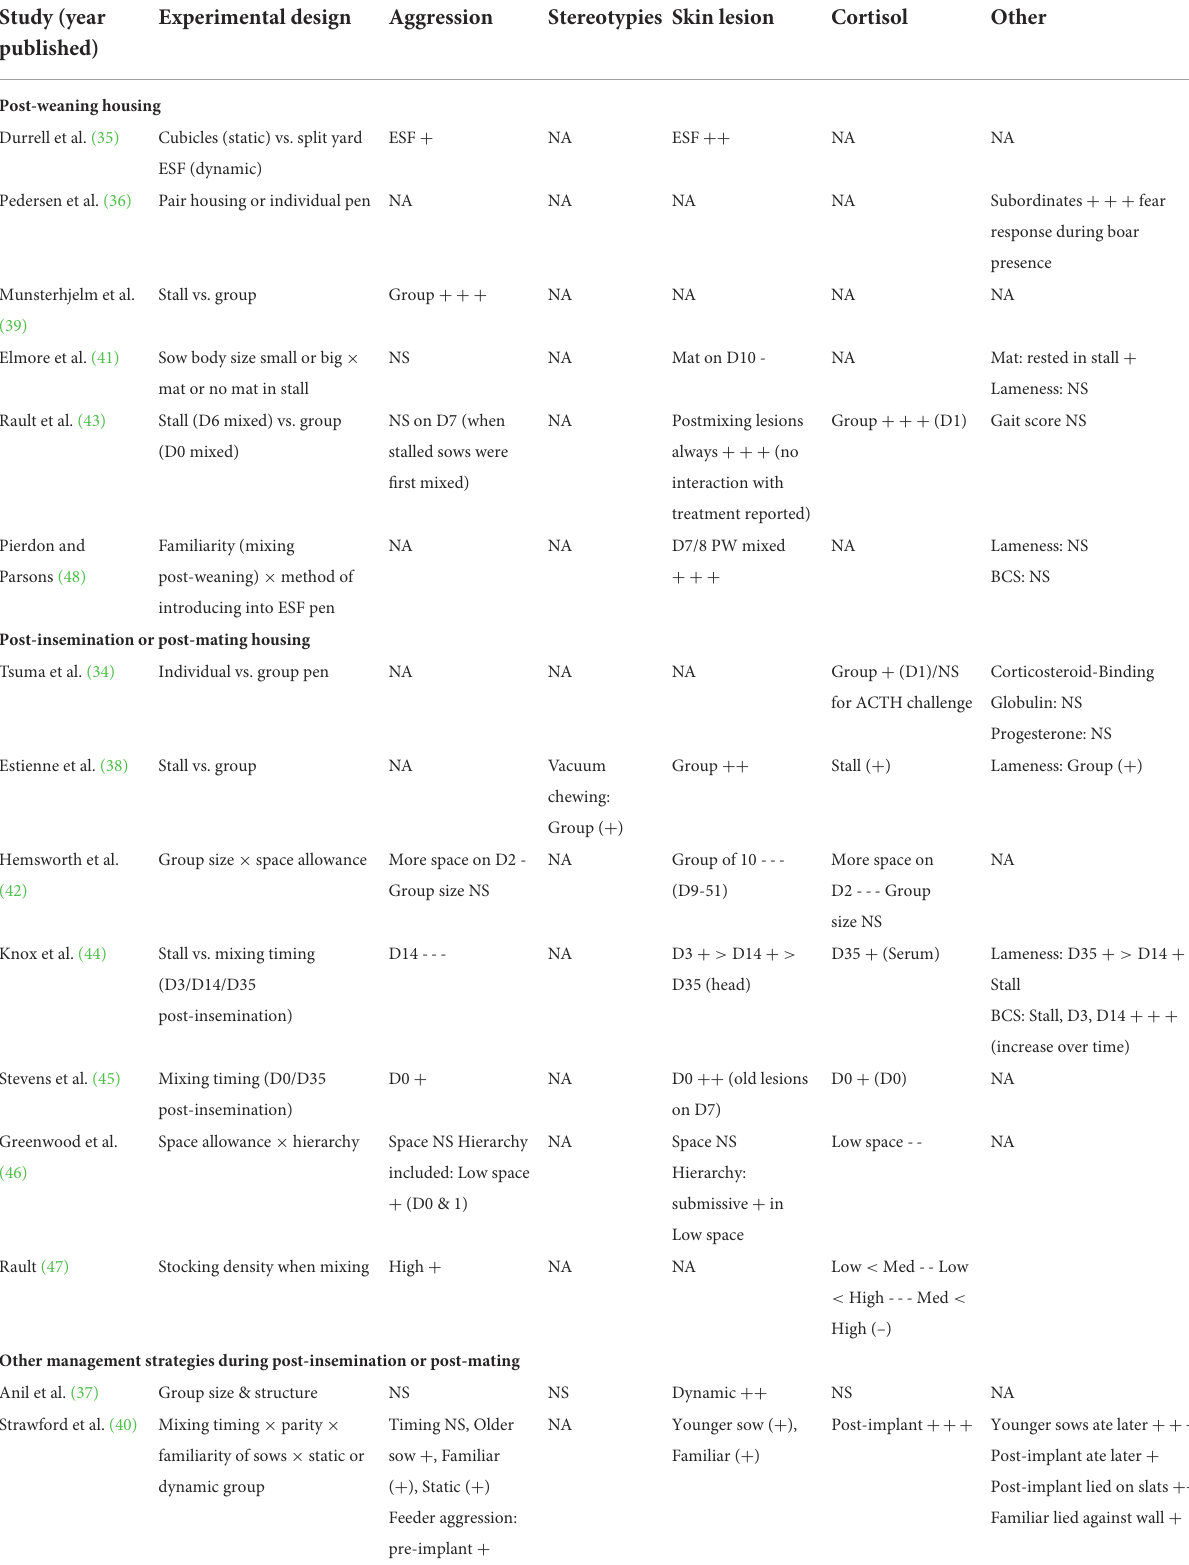
TABLE 4 Summary of the main effects of the welfare outcome measures in the experimental studies